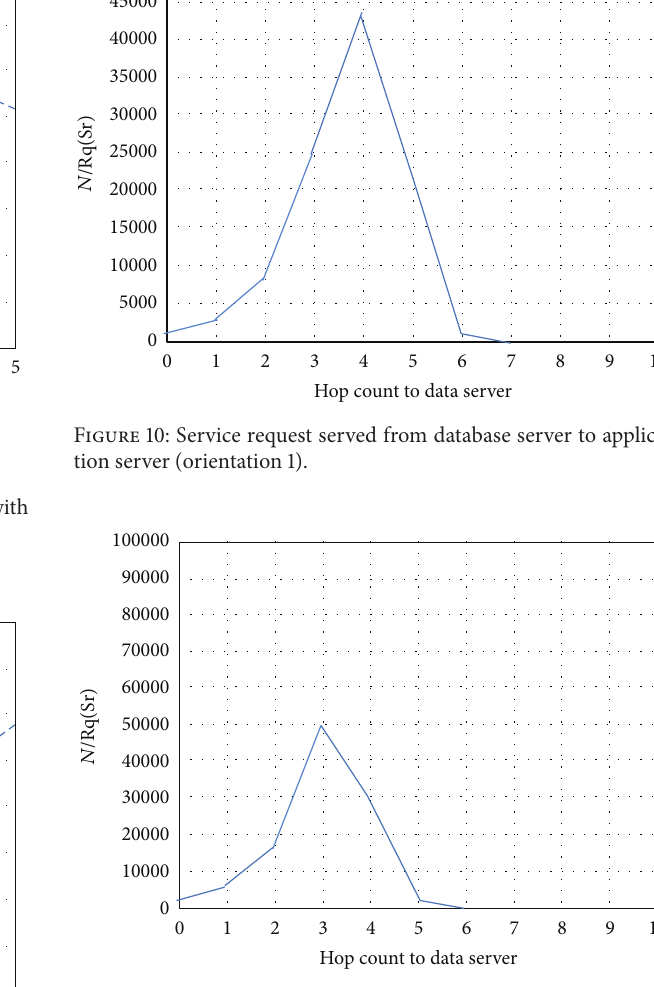
Figure 11: Service request served from database server to applica- tion server (orientation